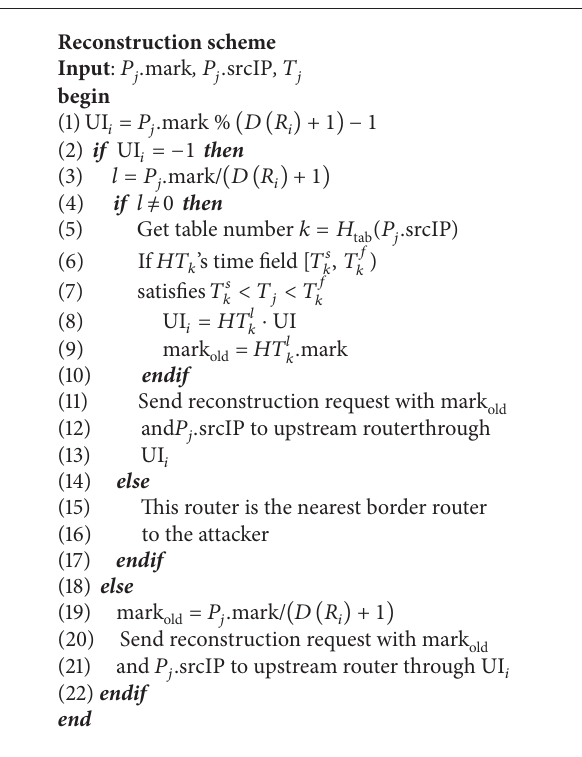
Algorithm 2: Path reconstruction scheme.